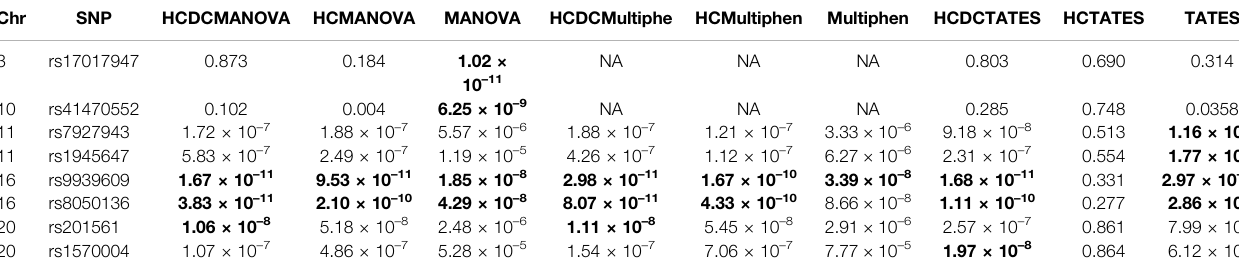
TABLE 4 | Display of signi fi cant SNPs and the corresponding p -values in the analysis of ARIC. Chr SNP HCDCMANOVA HCMANOVA MANOVA HCDCMultiphe HCMultiphen Multiphen HCDCTATES